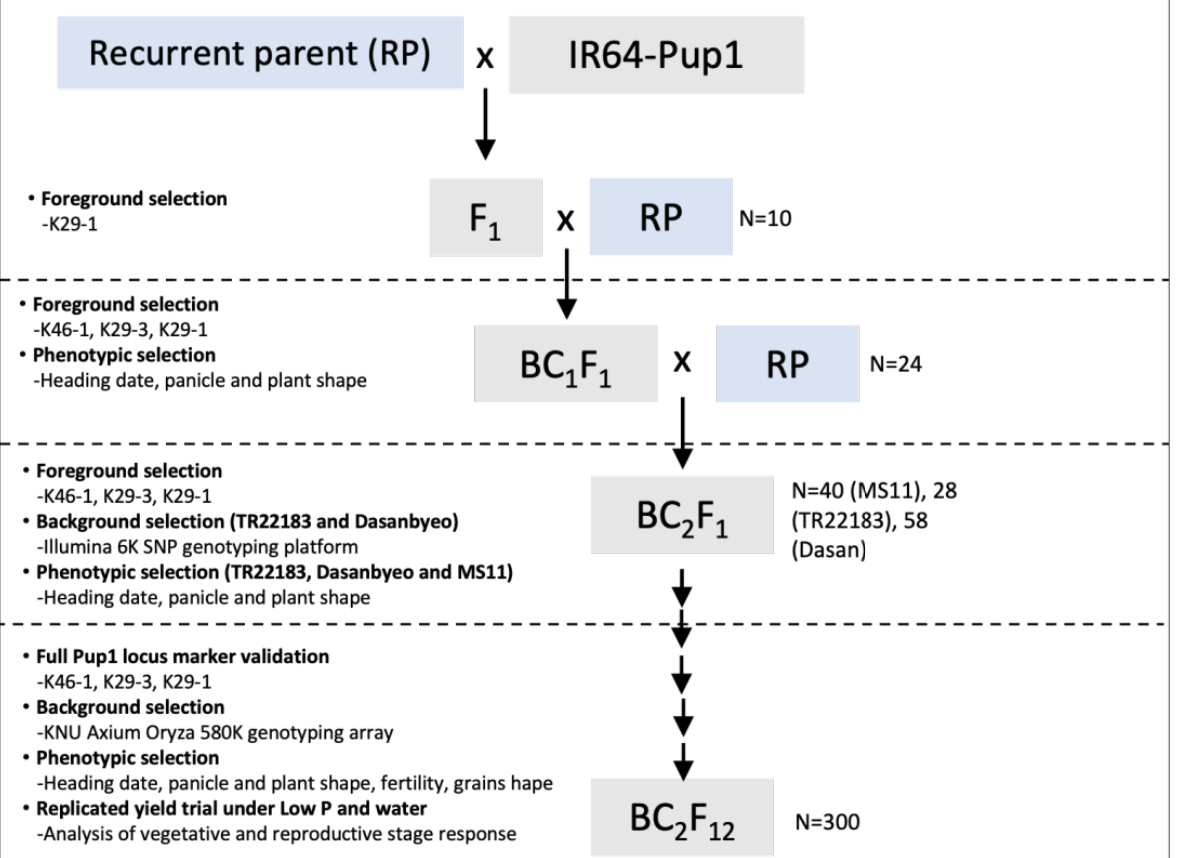
Figure 1. Marker-assisted breeding scheme for the introgression of Pup1 into MS11, TR22183, and Dasanbyeo.